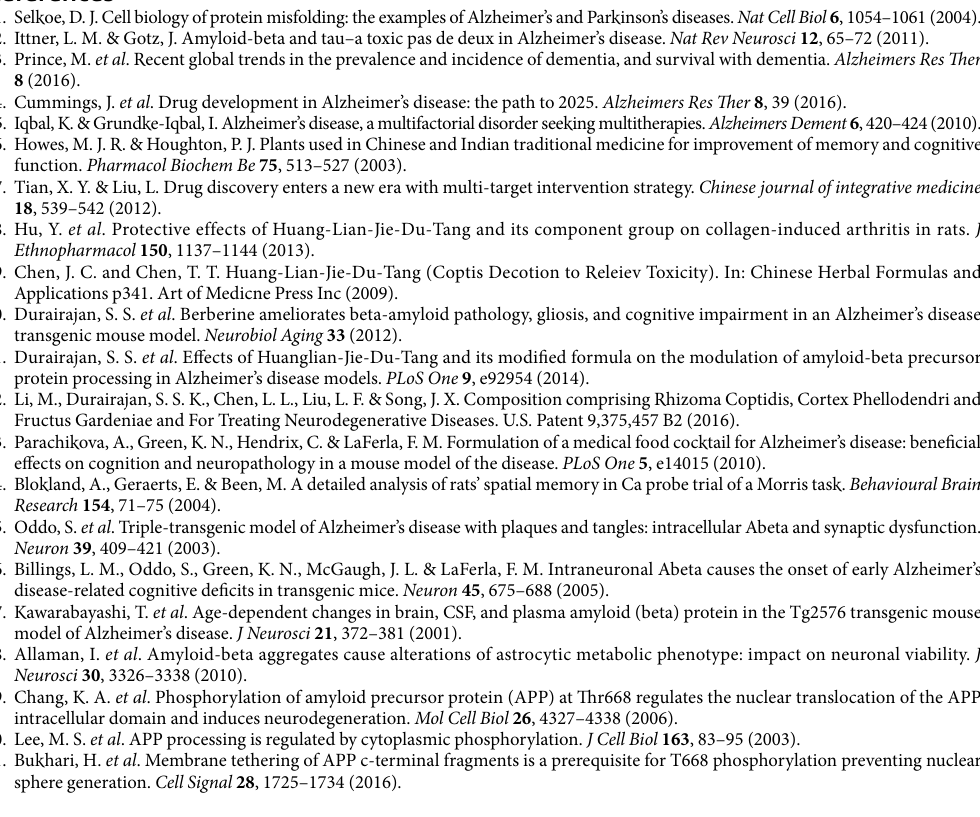
Statistical analysis. All data are represented as mean ± standard error of the mean (SEM). Analyses of behavioral data were performed using repeated-measures (“treatment” and “day”) 2-way analysis of variance (ANOVA). Data from the probe trial and immunhistochemistry was analyzed by One-way ANOVA analysis. Pair-wise differences between groups were compared using either Bonferroni’s or Fisher’s least significant differ- ence (FLSD)-post hoc multiple comparisons test. All graphical presentation and statistical tests were executed with GraphPad Prism 6 (GraphPad Software, San Diego, CA, USA).